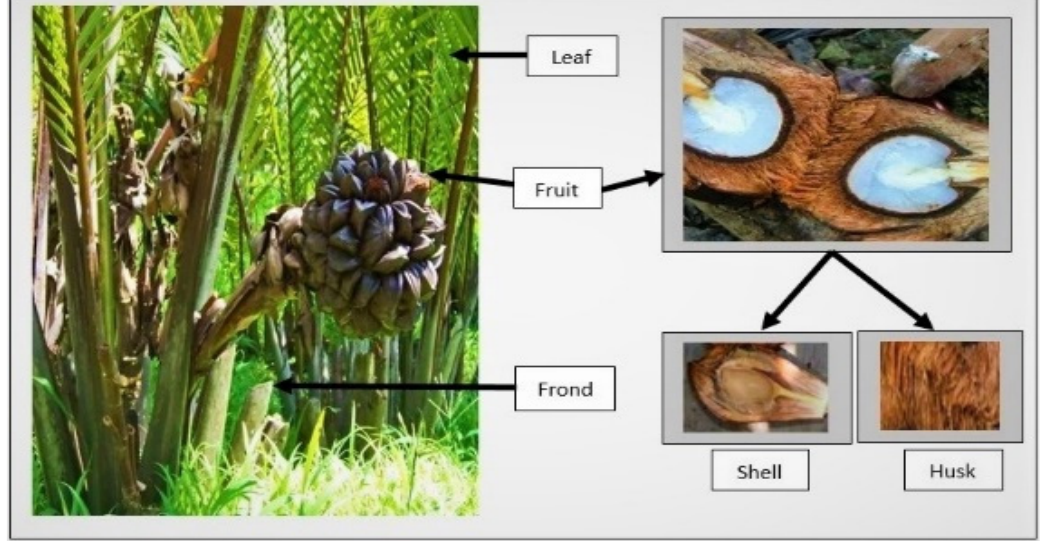
Figure 1. Potential parts of the nipa palm as raw materials for fuels and chemicals.